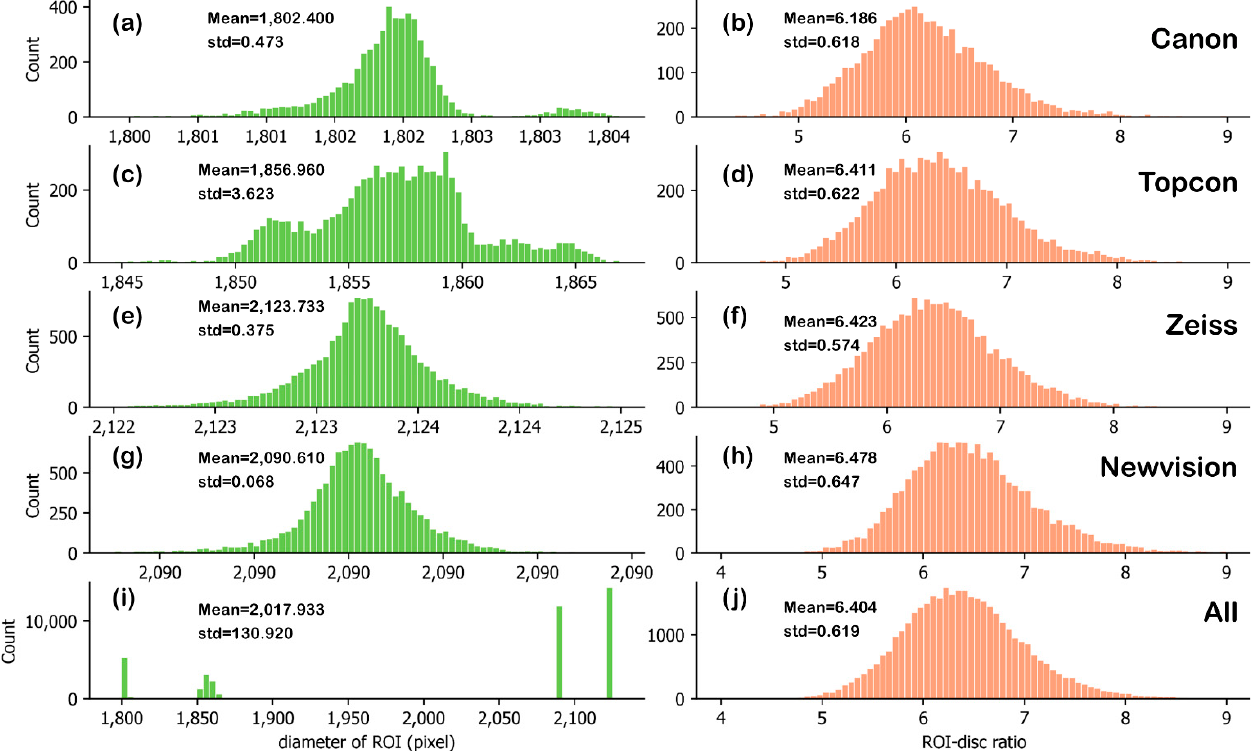
Figure 7. Statistics results of diameter of ROI and ROI–disc ratio for Canon ( a , b ), Topcon ( c , d ), Zeiss ( e , f ), Newvision ( g , h ), and all the cameras ( i , j